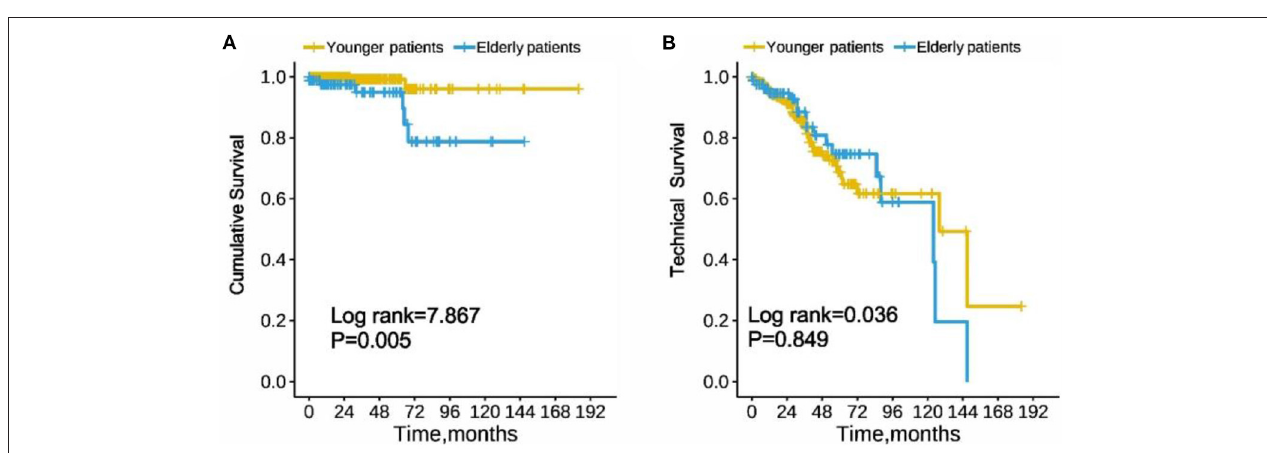
FIGURE 2 | Cumulative survival (A) and technique survival (B) of elderly and younger patients with peritoneal dialysis-associated peritonitis. (Log-rank test χ 2 = 7.867, p = 0.005 and Log-rank test χ 2 = 0.036, p = 0.849, respectively).